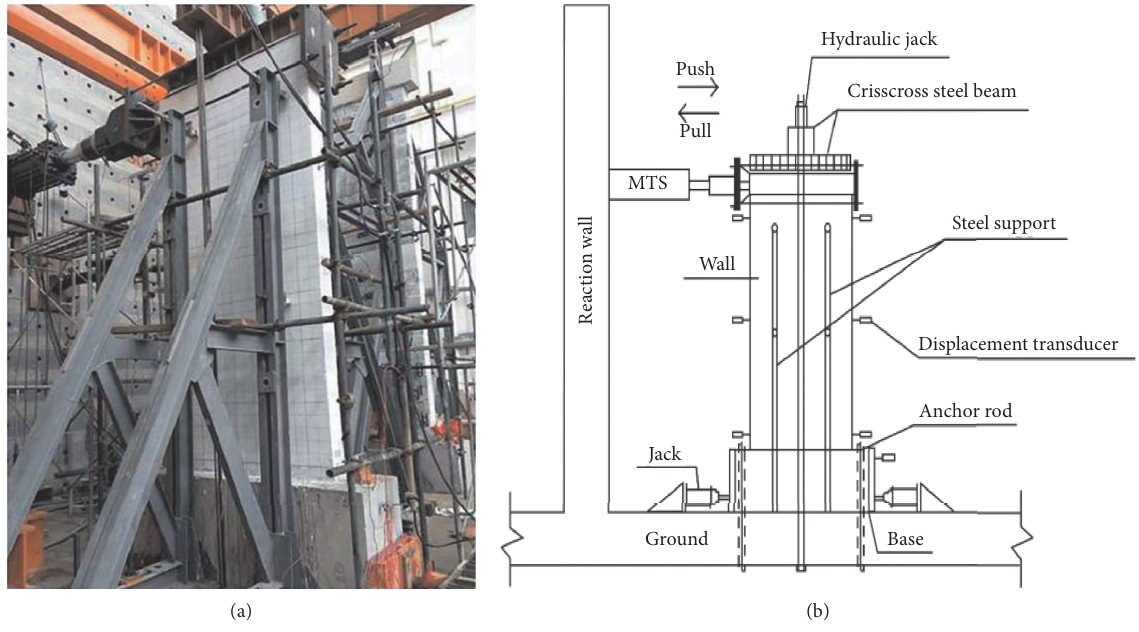
Figure 10: (a) Experimental specimen picture; (b) test setup.